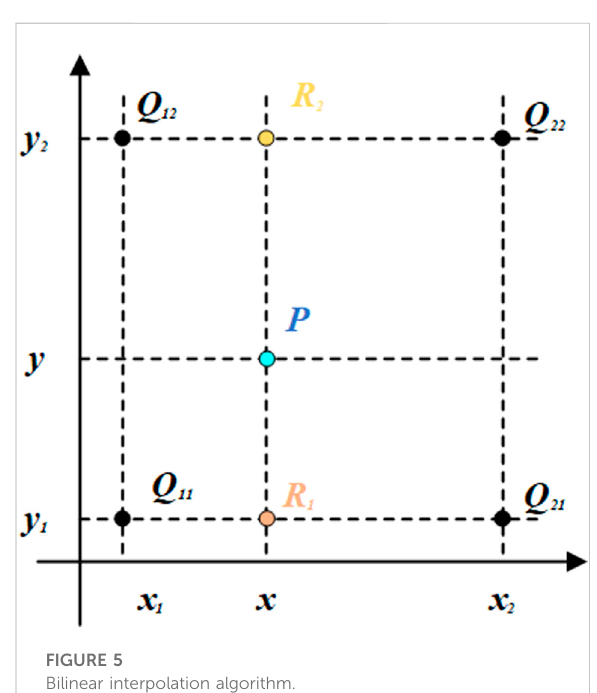
FIGURE 5 Bilinear interpolation